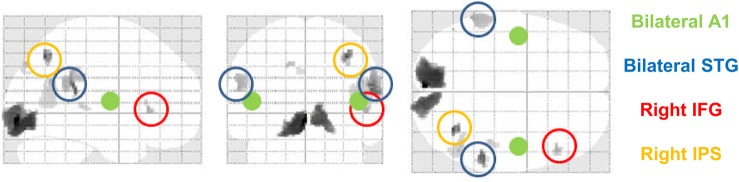
Source selection for DCM. Network nodes were selected based on a multiple sparse priors source reconstruction of the mismatch response (deviants vs. standards) using a time window in which there was a significant interaction between attention and expectation. Sources in STG, the right IFG, and the right intraparietal sulcus (IPS) were used to model the observed effects. Additionally, sources in bilateral primary auditory cortices (A1) were included in all models. See main text for details.